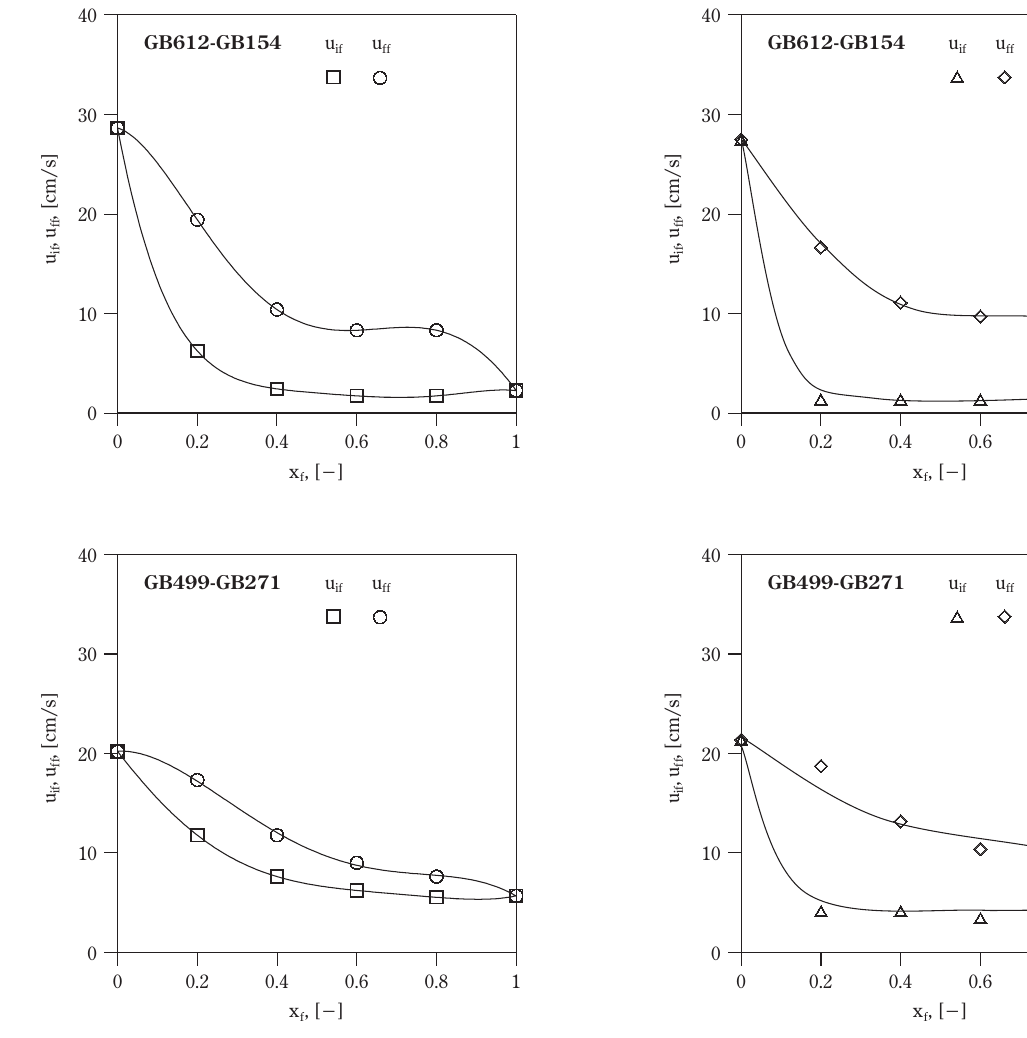
Figs. 9 and 10 for mixed and segregated beds, re- spectively.